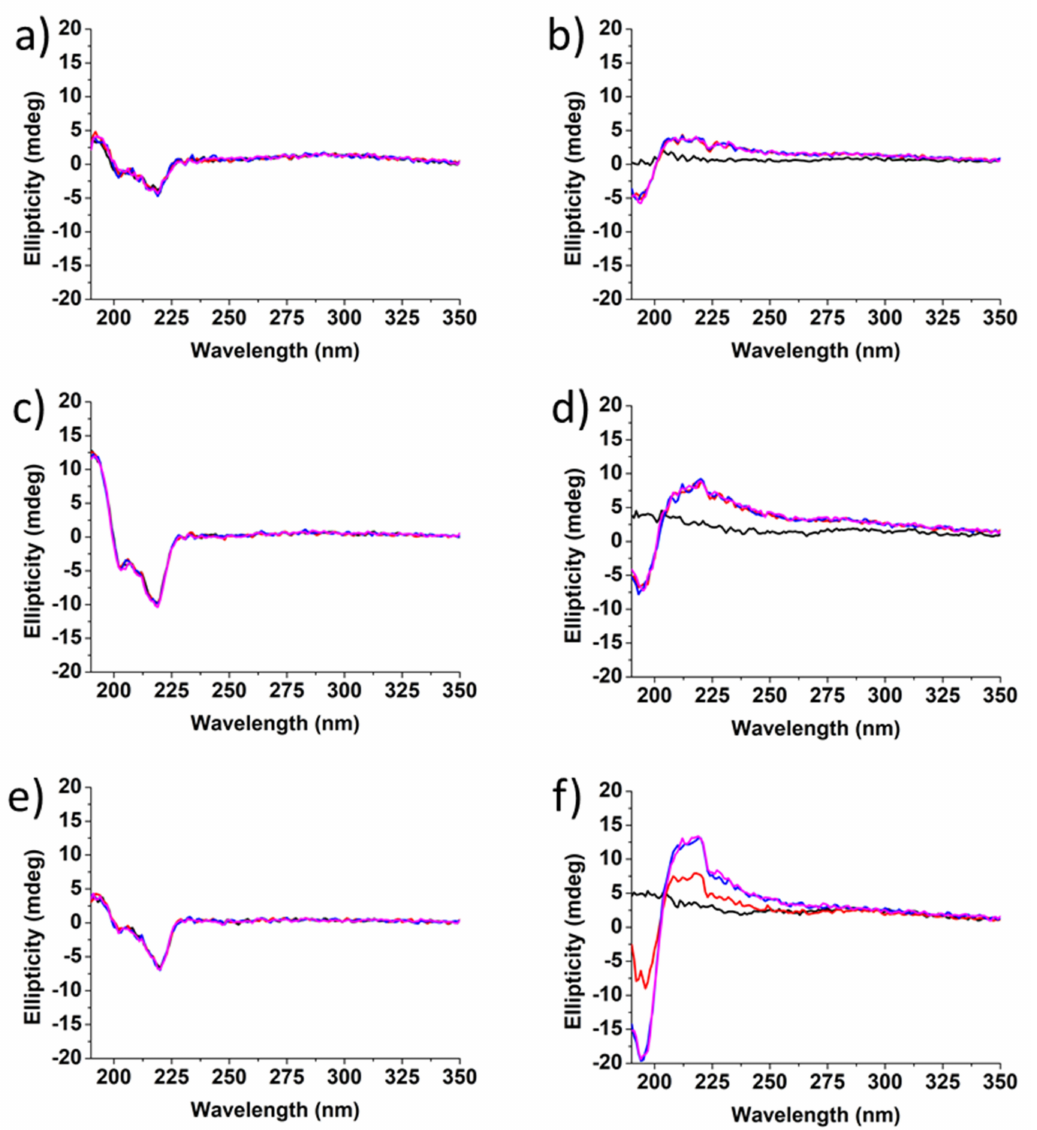
Figure 7. CD spectra of ( a ) Boc- β 3 ( R )Phe- β 3 ( R )Phe-OH; ( b ) Boc- γ 4 ( R )Phe- γ 4 ( R )Phe-OH; ( c ) Boc- β 3 ( R )Phe- β 3 ( R )Phe-OH + 0.025 wt% ox-CNTs; ( d ) Boc- γ 4 ( R )Phe- γ 4 ( R )Phe-OH + 0.025 wt% ox-CNTs; (black = directly after the addition of HCl into the cuvette at t0, red = after 10 min, blue = after 20 min, magenta = 30